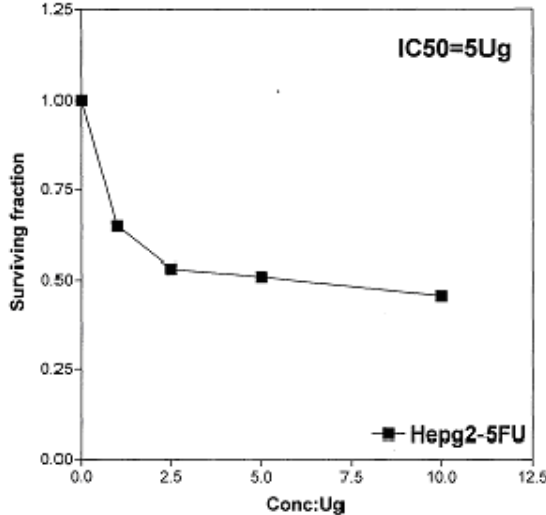
Figure 10. Effect of conc. of 5-fluorouracil (standard) on HEPG2